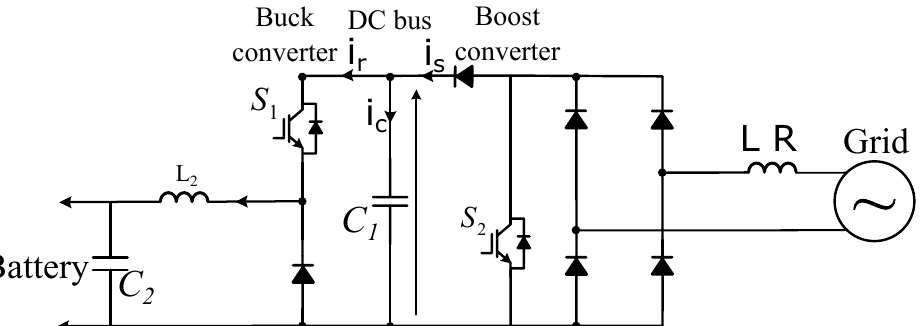
Figure 11. Unidirectional battery charger for